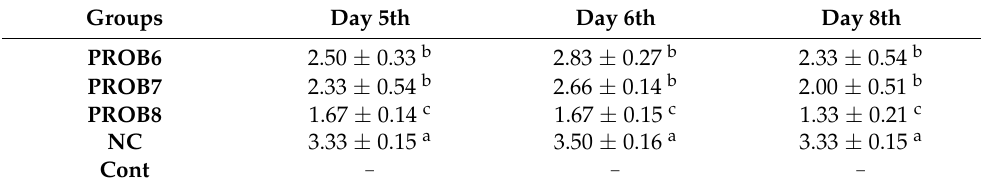
Table 2. Fecal score in chickens ( n = 6) with experimentally induced coccidiosis in different treated